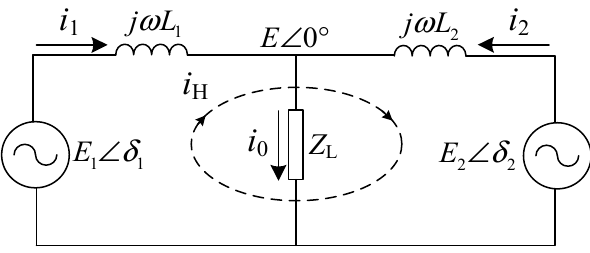
Figure 4. Converter’s parallel operation.